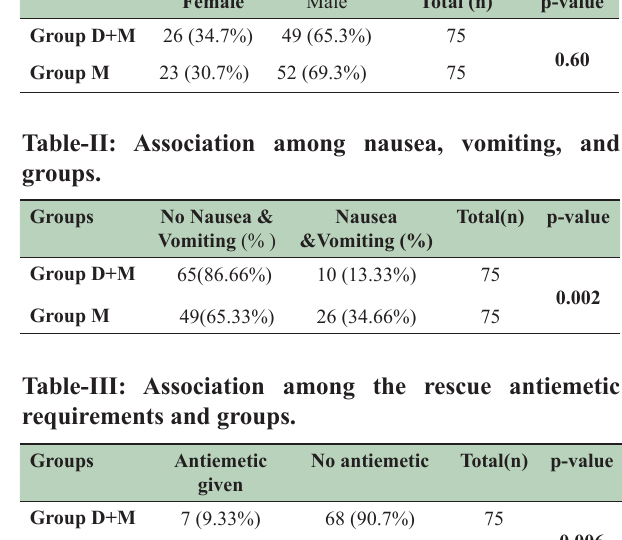
Table-IV: Association among the hospital stay time and